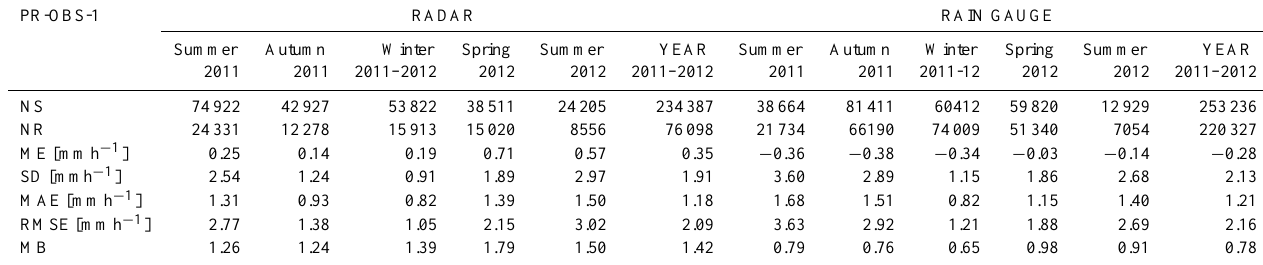
Table 7. Continuous indicators for PR-OBS-1: NS (number of considered satellite product samples); NR (number of reference field samples); ME (mean error); SD (standard deviation of ME); MAE (mean absolute error); RMSE (root mean square error); MB (multiplicative bias).